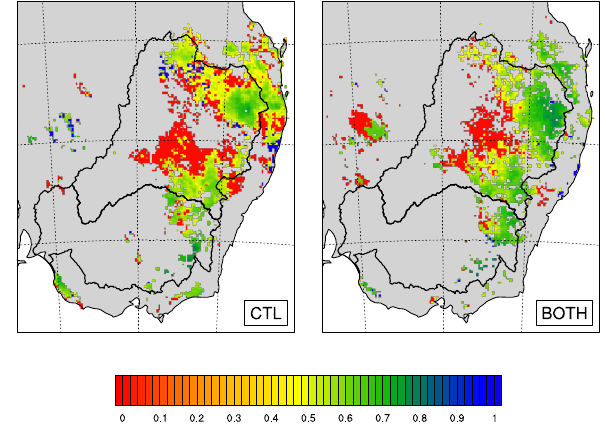
Figure 13. Ratio of the contribution of decreases in total turbulent fluxes and increases in PBL height to decreases in moist static en- ergy density in the PBL during the 2006 drought peak. Red indicates that only decreases in turbulent fluxes contribute, blue indicates that only increases in PBL height